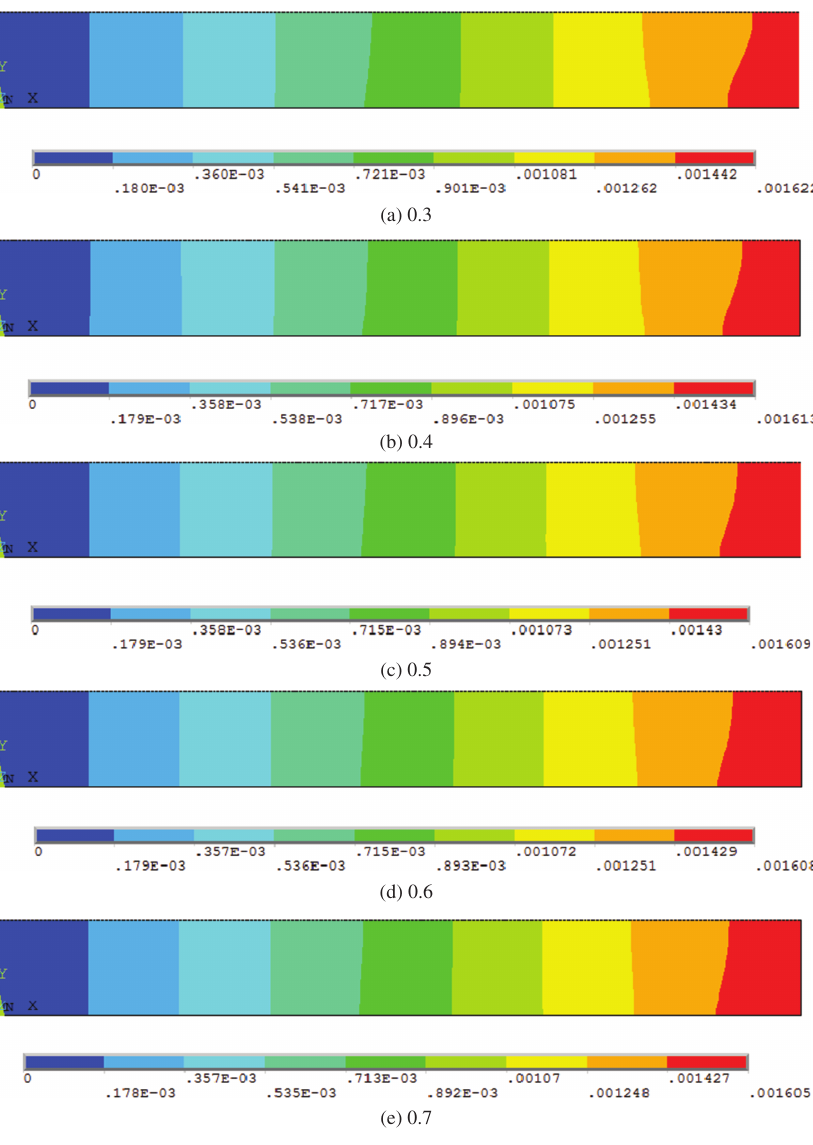
Figure 6: Displacement nephogram along width direction of slab under different solid phase